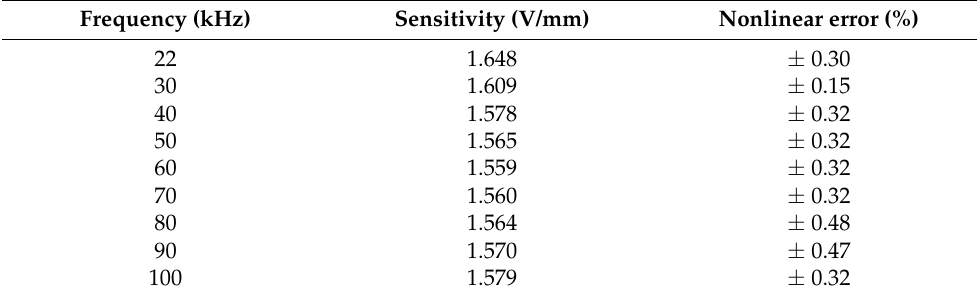
Table 4. Sensitivity and nonlinear error of the theoretical model considering core eddy current.